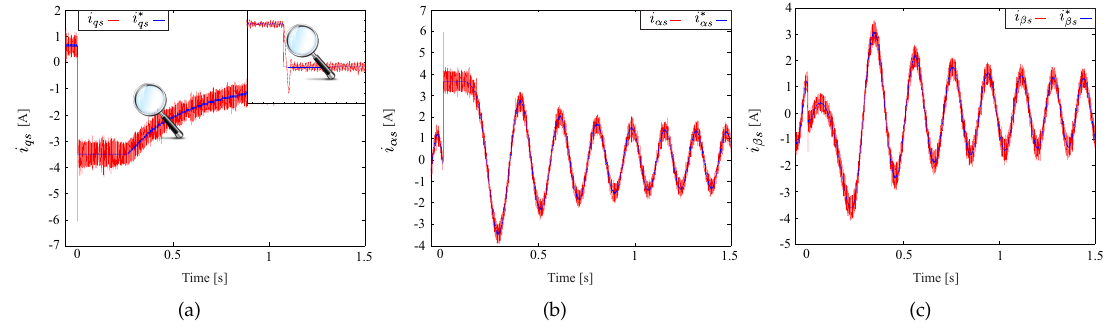
Figure 6. Transient response of stator currents from a step response of 500 rpm to − 500 rpm from ω m at a frequency sample of 16 kHz: ( a ) i qs ; ( b ) i α s ; ( c ) i β s